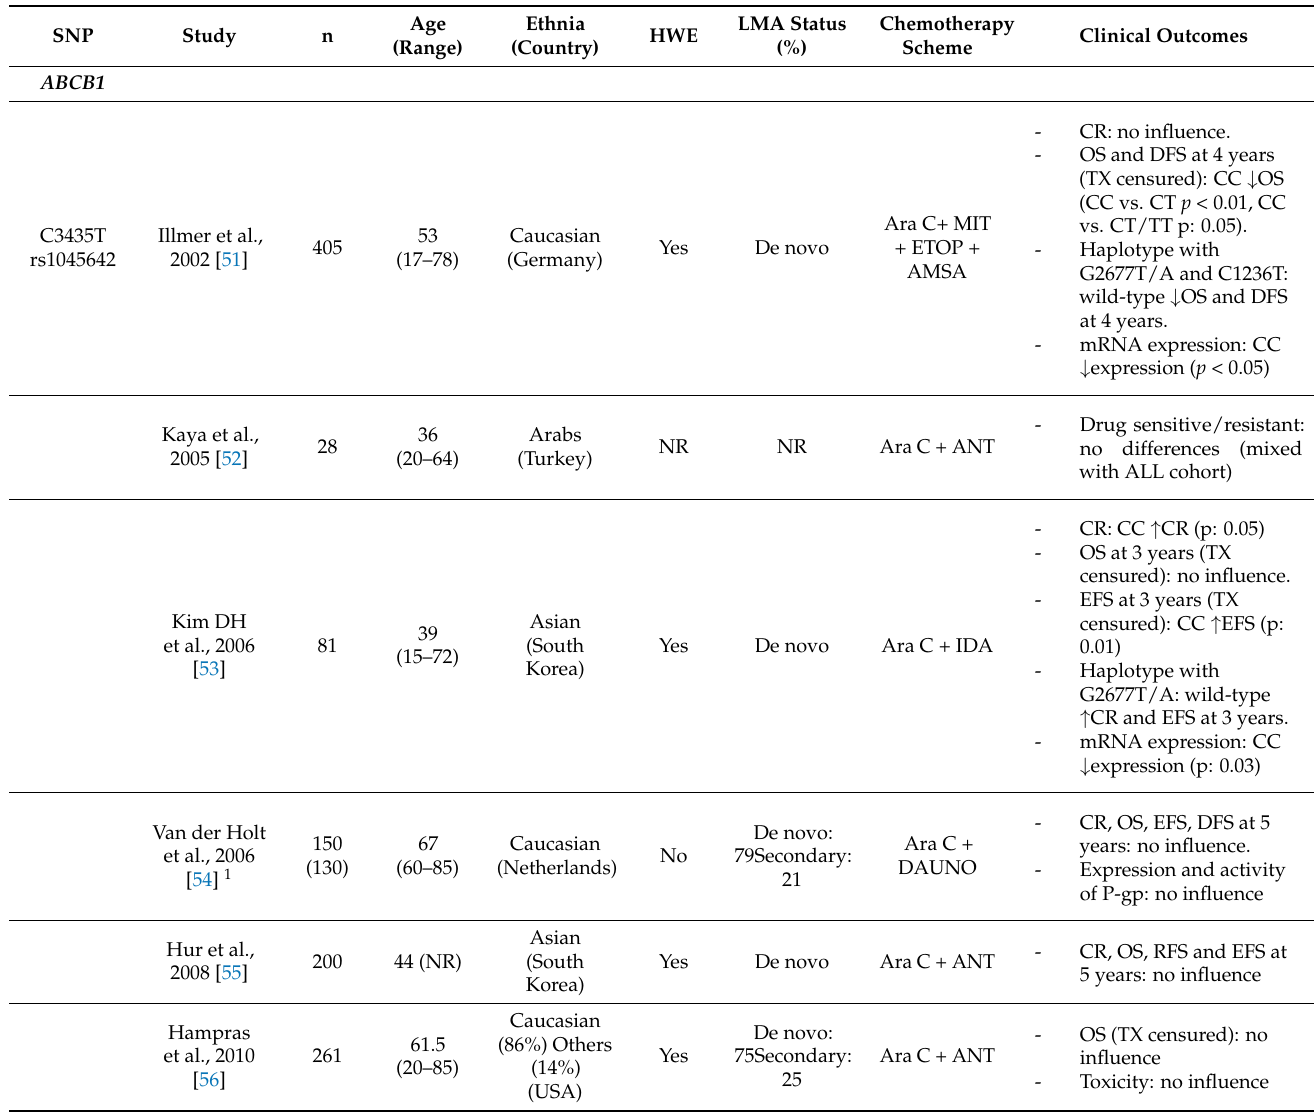
Table 2. Characteristics of the studies included in the systematic review for polymorphisms of the ABC transporter